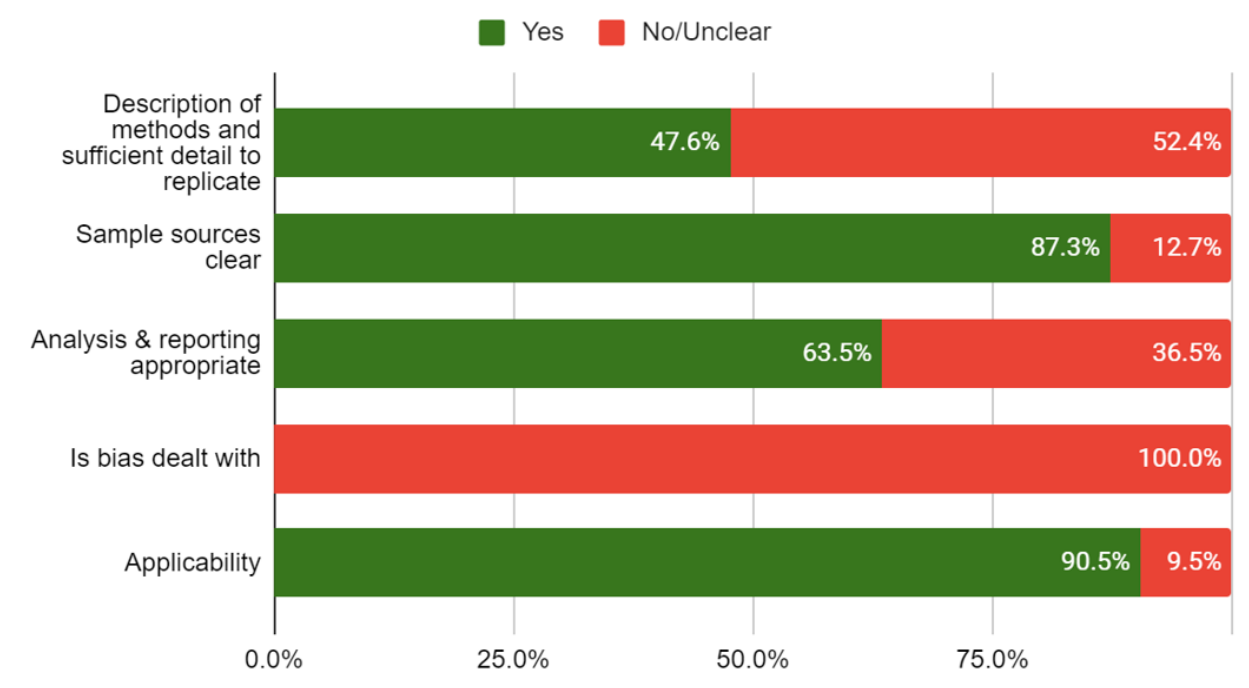
Figure 2. Risk of bias (n=63 primary studies).